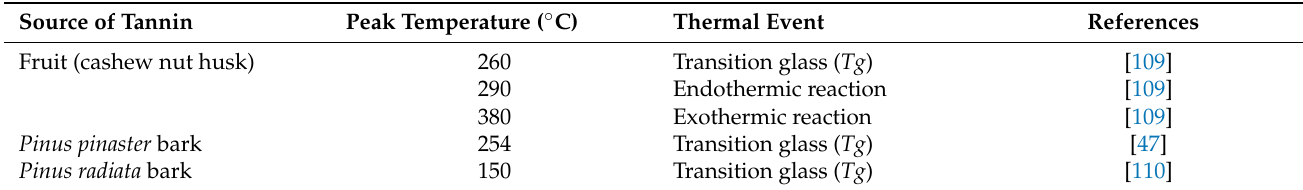
Table 4. Thermal behavior of bio-PU resins from different sources of